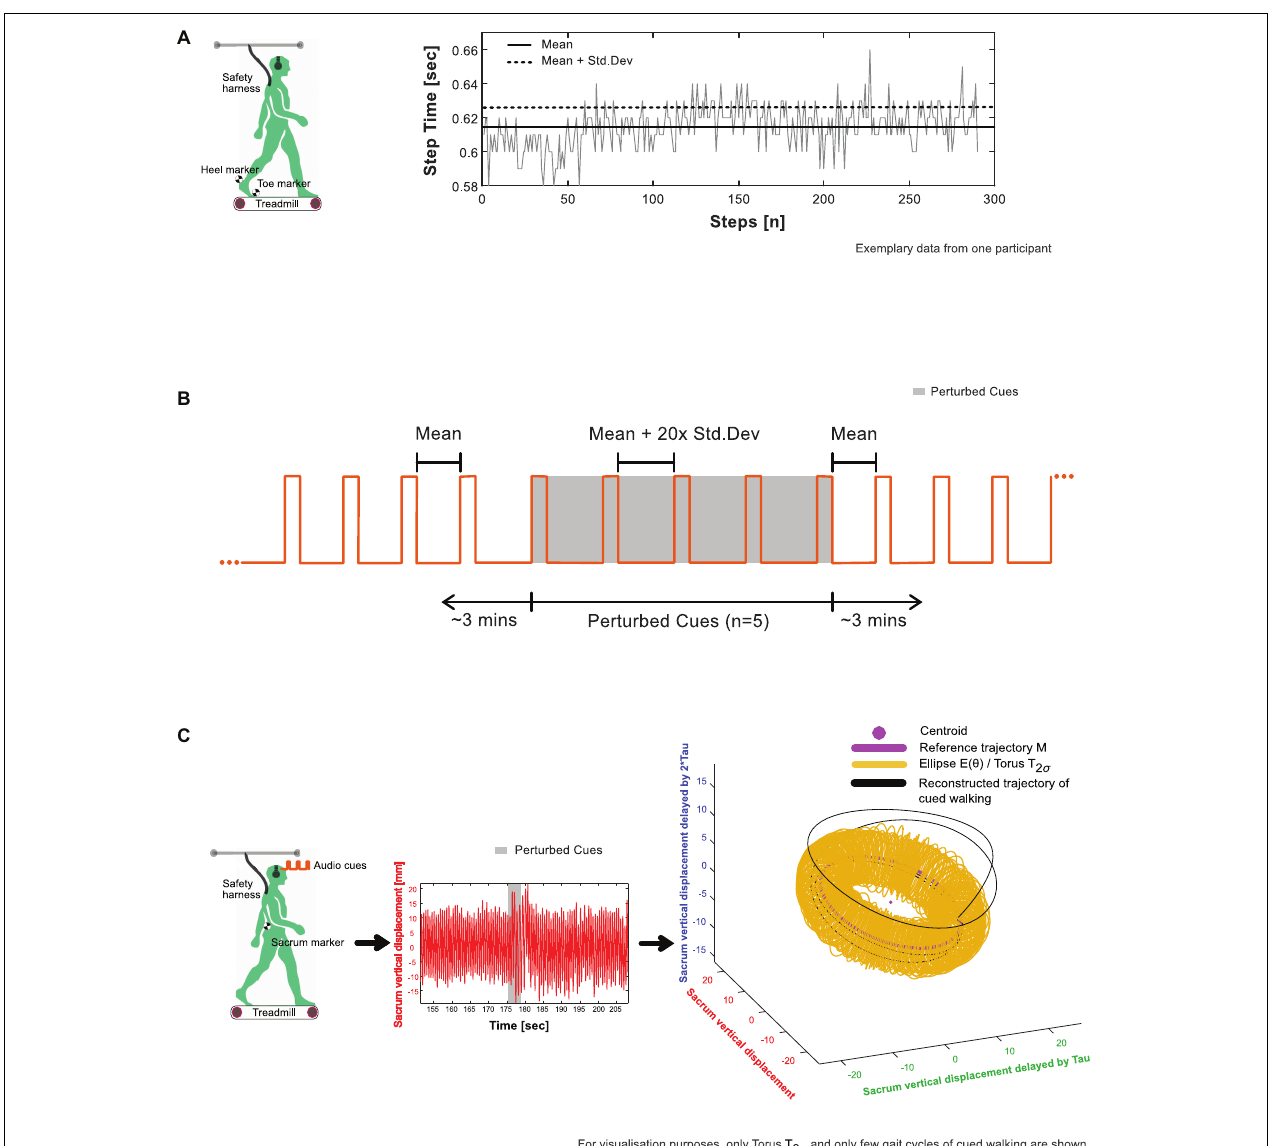
FIGURE 1 | Experimental procedure. (A) Extraction of average (mean and standard deviation) step time characteristics from baseline walking 1 (BW1) shown in an exemplary participant. The timing of heel strike and toe off, the events that mark the step time of walking were identified using a custom foot velocity algorithm. (B) Generation of subject-specific metronome audio-tracks using BW1 step time characteristics. The inter-beat intervals of the metronome were matched to the mean step time. To induce perturbations, the created track was adjusted by embedding five perturbation intervals, where the inter-beat intervals were increased by 20 × the standard deviation of the step time and introduced around 3 min into the track. (C) Observation of perturbation response in an exemplary participant’s center of mass movement (approximated in our study using the vertical displacement time series of the sacrum marker) with respect to their steady state boundaries given by the toruses (see section “Determination of Steady State COM Using Baseline Walking 1” in the manuscript for methodological details).